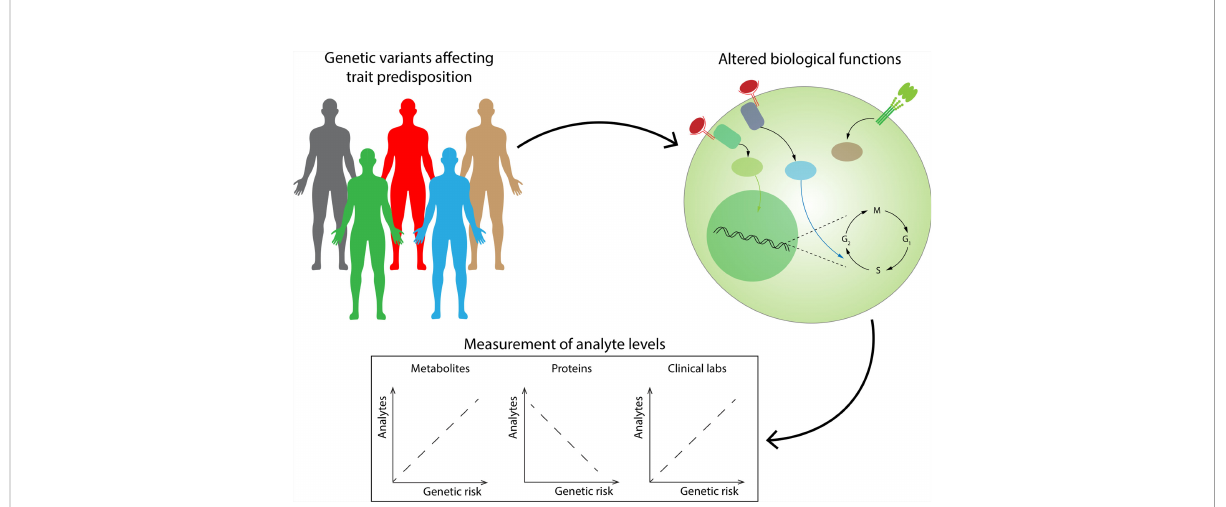
FIGURE 2 Healthy individuals with high genetic risk scores for a speci fi c trait have already detectable abnormalities in several blood analytes. Genetic risk scores generated from risk variants for several traits have been associated with levels of plasma analytes (standard blood analytes, and proteomic and metabolic measurements), revealing that a nonnegligible level of dysregulation of these analytes can already be found in healthy subjects with high genetic risk. These approaches could be potentially leveraged for early detection of